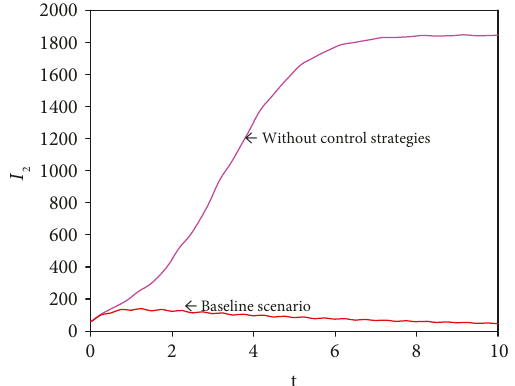
Figure 6: Time series plot of the total infected trees for the baseline scenario and without control